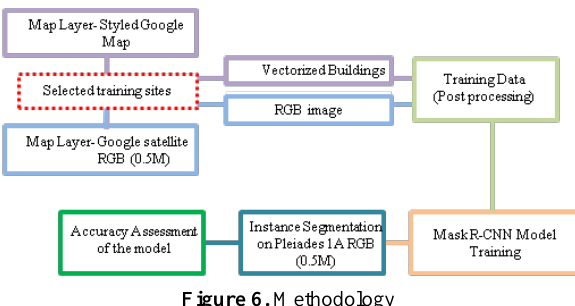
Figure 9. Default Google Map